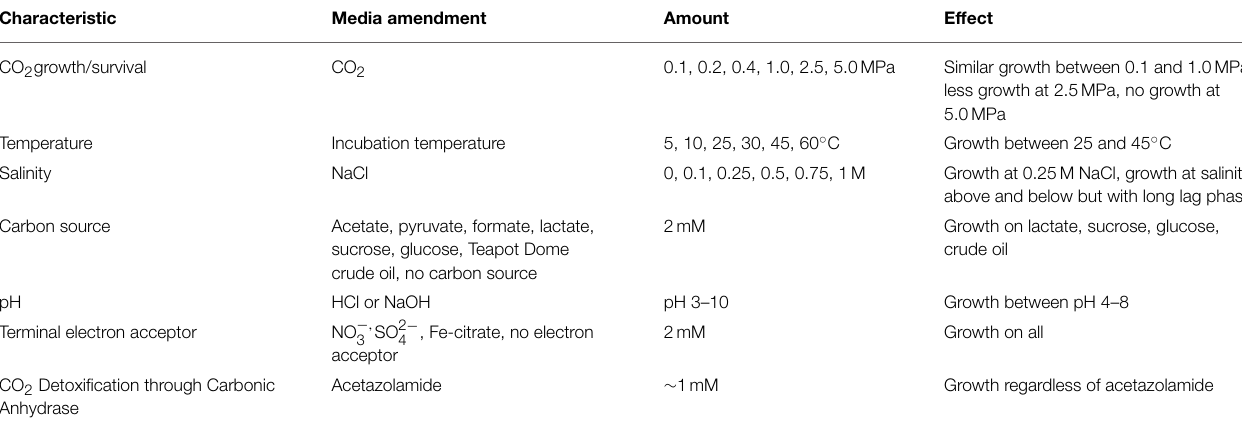
TABLE 1 | CG-1 physiological parameters